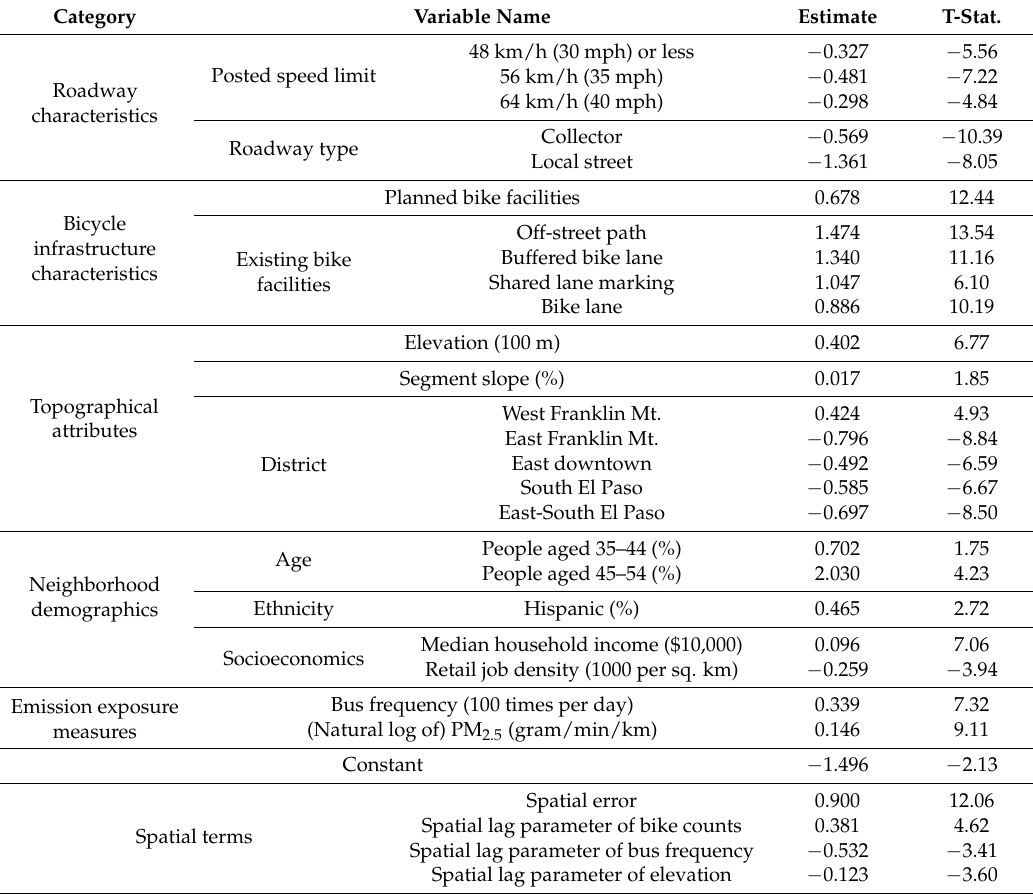
Table 4. Bicycle model